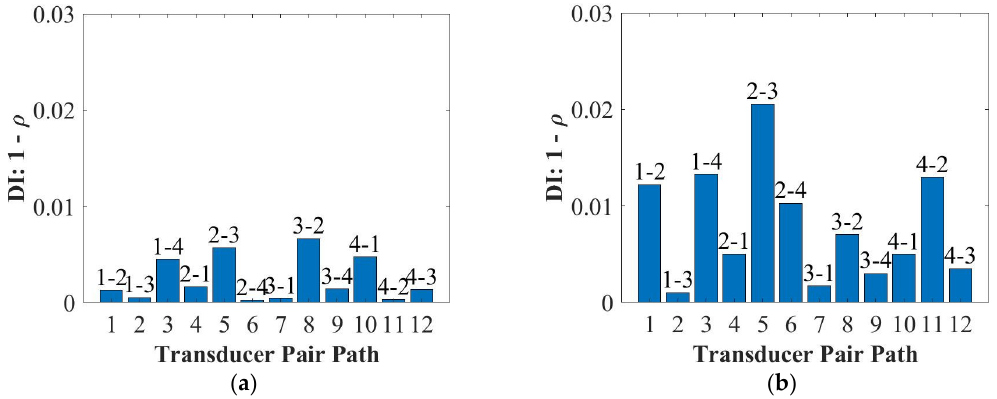
Figure 15. Damage detections for the 9 mm thick panel at 50 kHz ( a ) and 250 kHz ( b ).